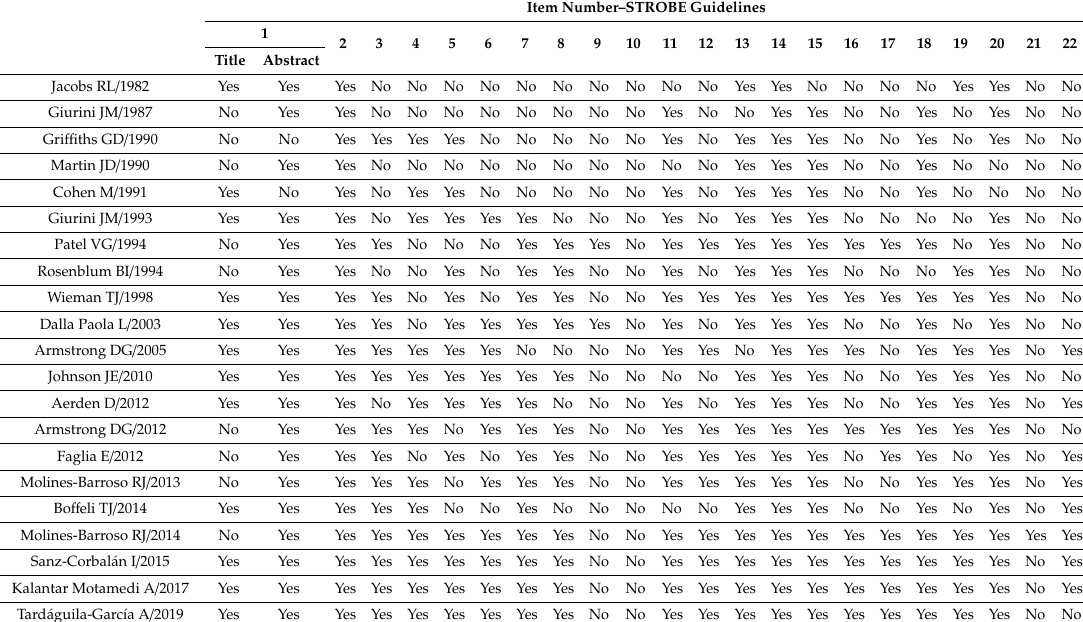
Table 2. Overall rating for Strengthening the Reporting of Observational studies in Epidemiology (STROBE)